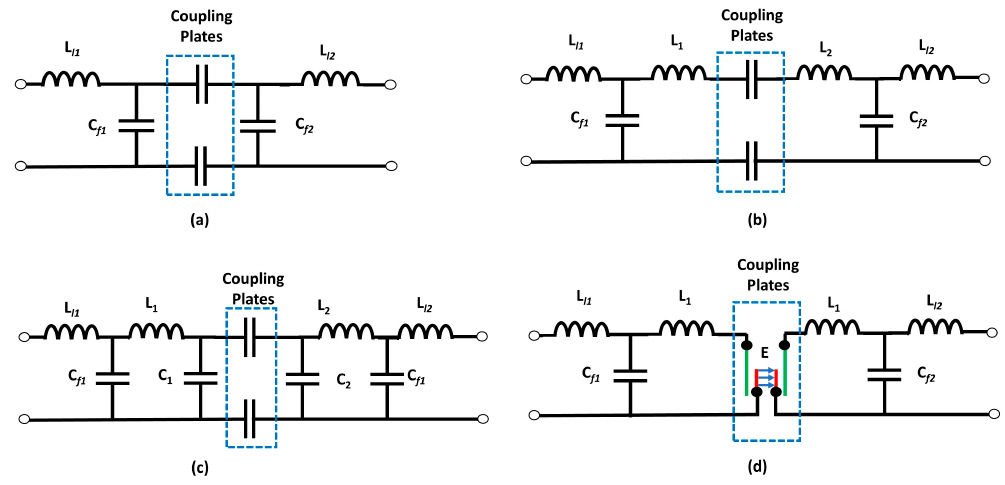
Figure 15. CPT compensation structures: ( a ) LC compensation; ( b ) LCL compensation; ( c ) LCLC compensation; and ( d ) LCL compensation with vertically stacked coupling plates [16].